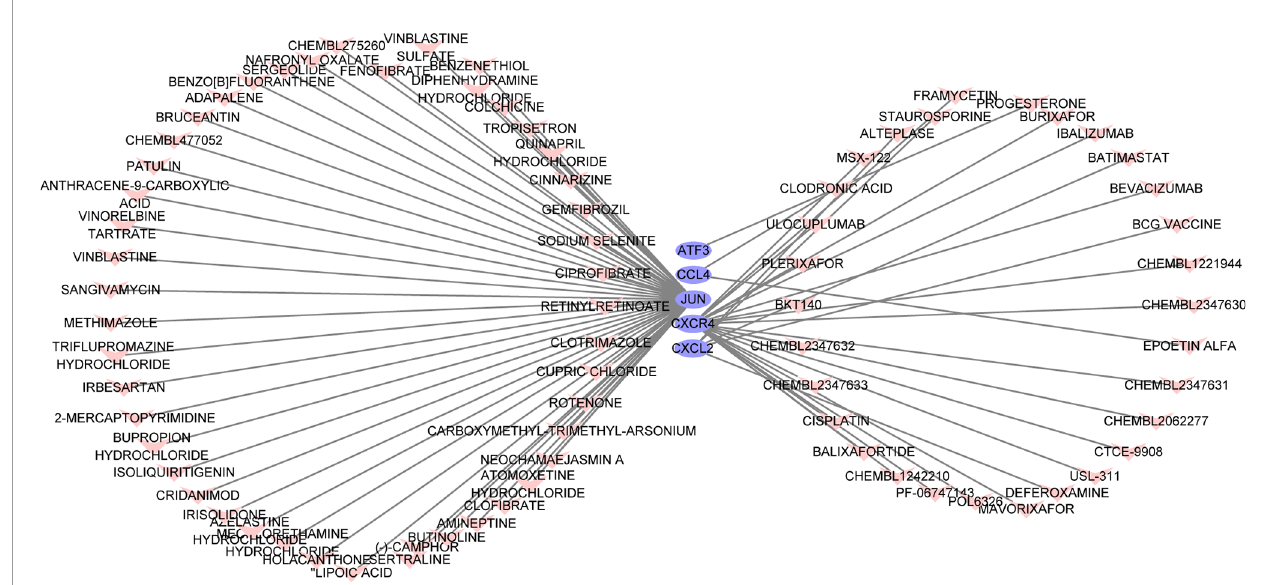
FIGURE 7 | The constructed mRNA-drug network. The purple oval represents the genes, and the light red heart represents the